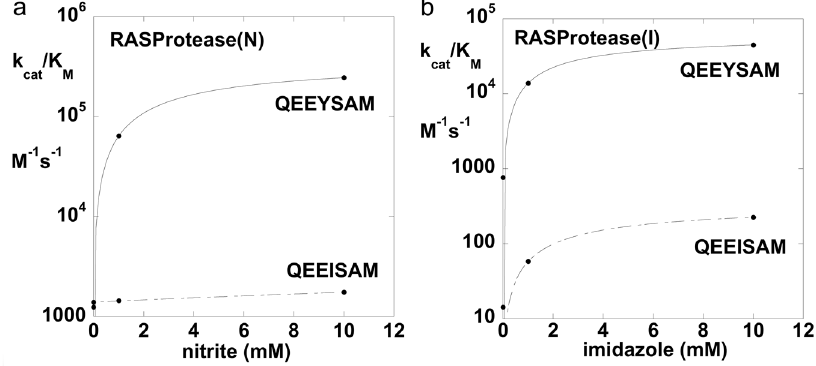
Fig. 4 Conformational and chemical rescue by native and near-native sequences. a k cat / K M as a function of nitrite concentration for RASProtease(N) with the substrates QEEYSAM-AMC and QEEISAM-AMC. ( b ) k cat / K M as a function of imidazole concentration for RASProtease(I) with the substrates